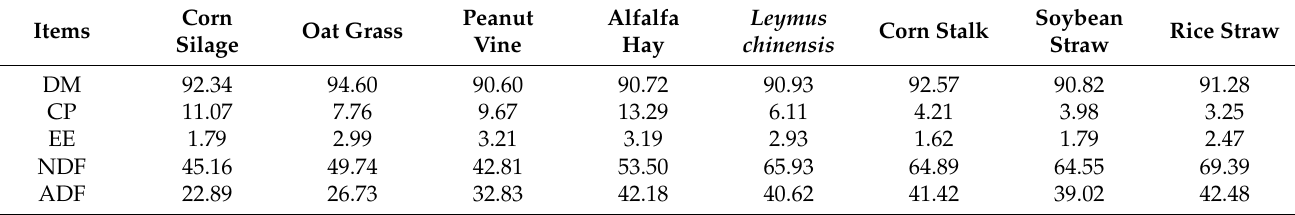
Table 2. Test the roughage nutrient levels (%, dry matter).